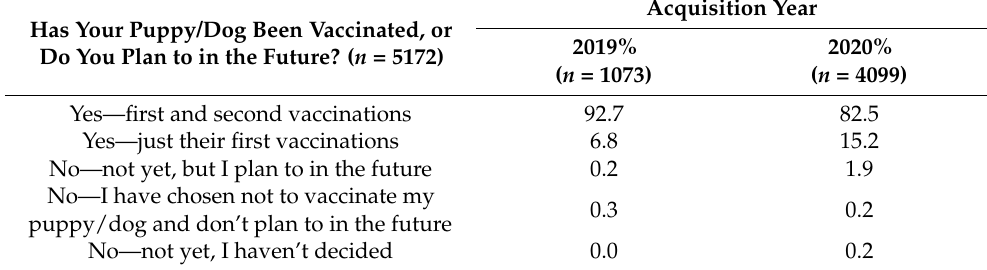
Table 6. Vaccination status of 2019 puppies ( n = 1073) and Pandemic Puppies ( n = 4099) as reported by the owners at the time of the survey in response to the question “Has your puppy/dog been vaccinated, or do you plan to in the future”. The answer options listed represent all the choices available to respondents.